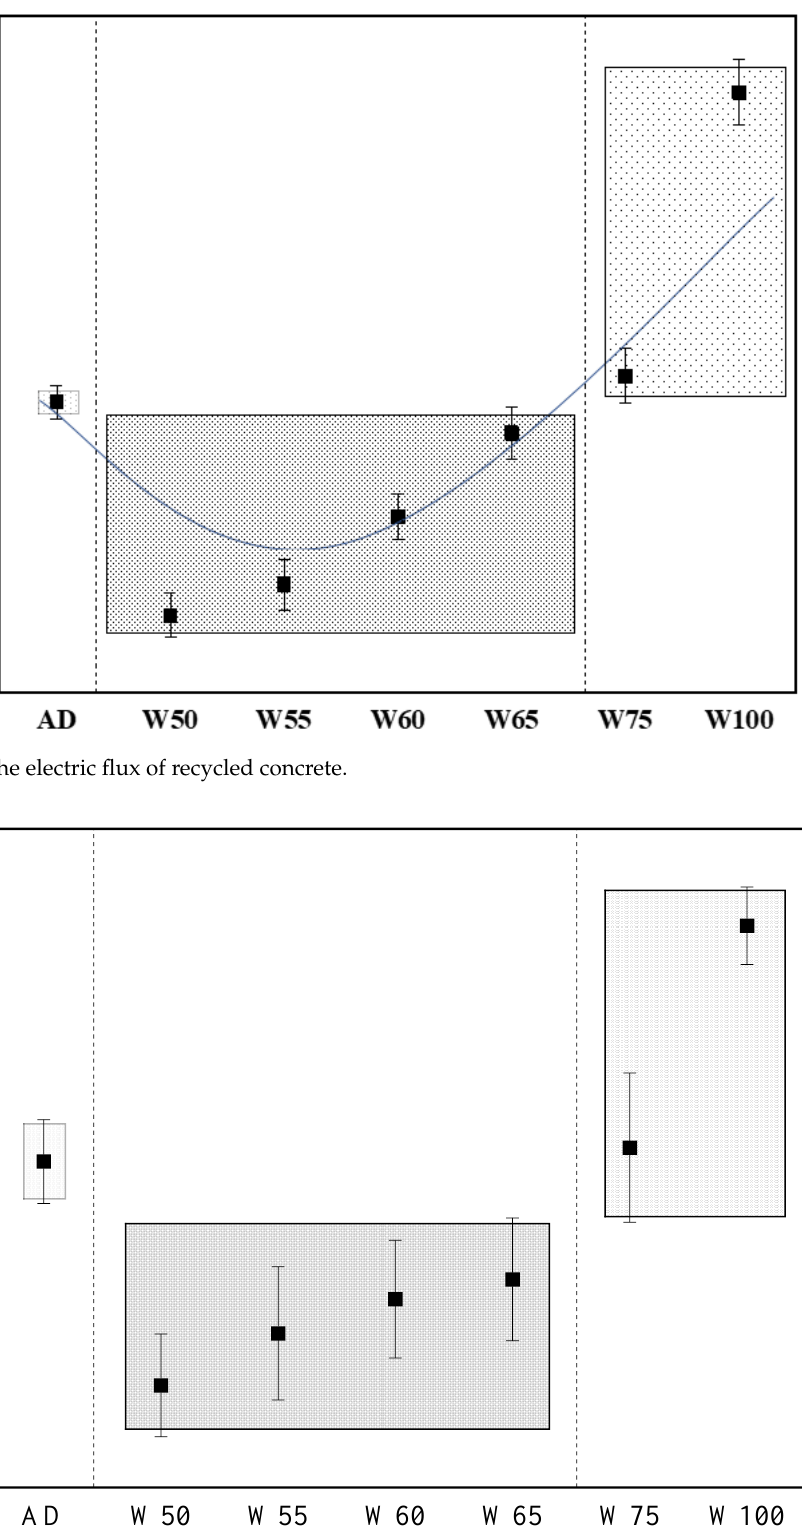
Figure 15. 28 d chloride diffusion coefficient of recycled concrete.